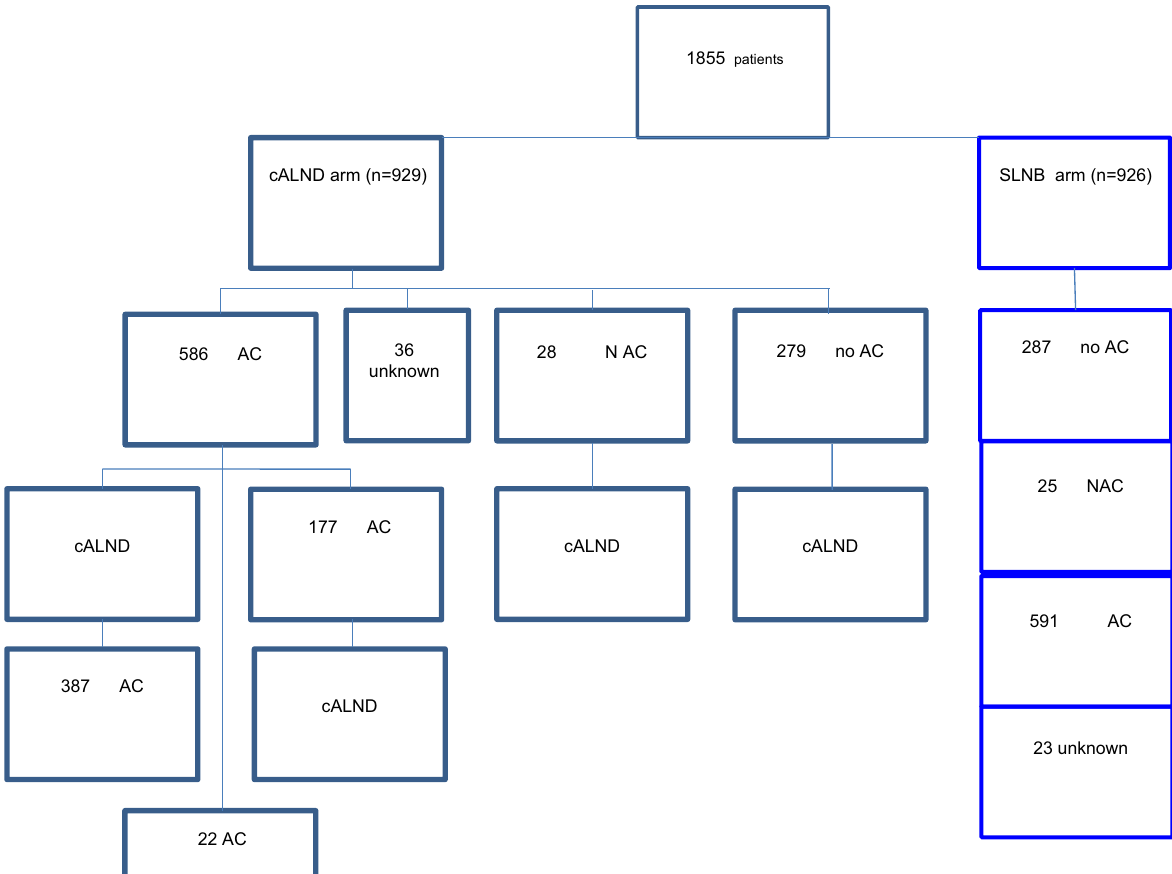
Fig. 2 Flow chart. Chemotherapy according to each arms, CALND and SLNB alone. cALND completion axillary lymph node dissection, SLNB sentinel lymph node biopsy, AC adjuvant chemotherapy, NAC neo-adjuvant